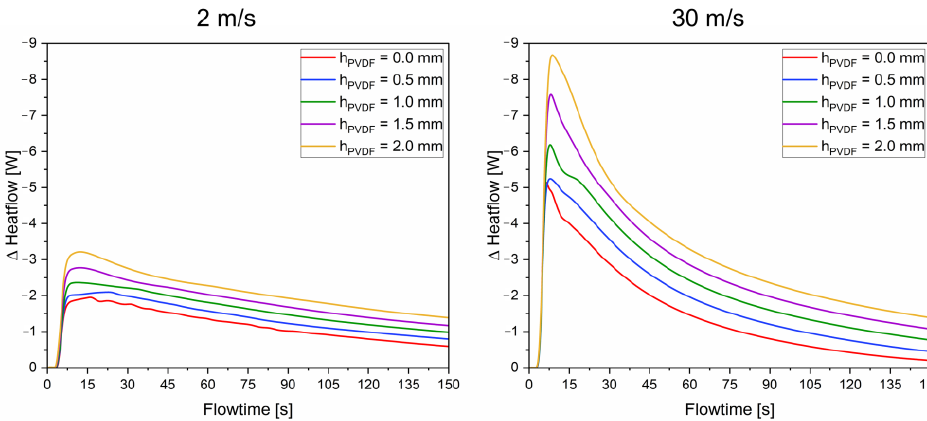
Figure 8. Heat flow independent of flowtime and shell thickness.